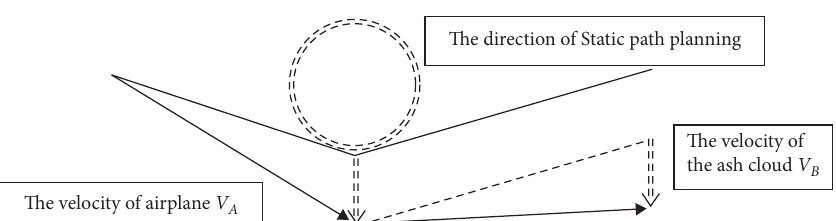
Figure 5: Path planning when the ash cloud